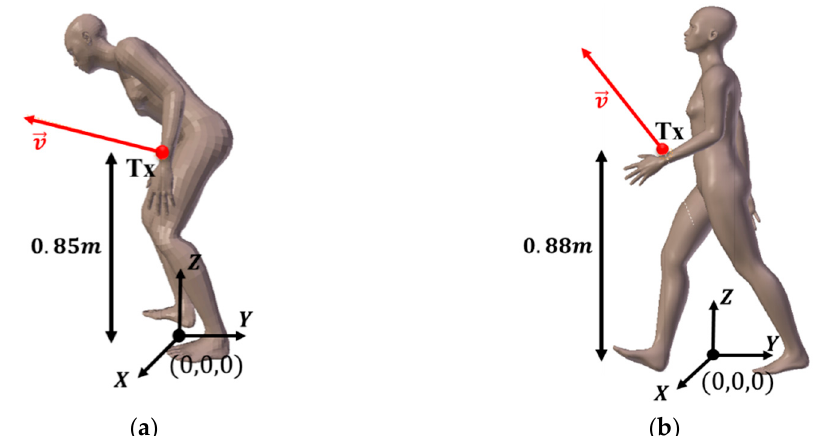
Figure 2. Illustration of 3D human body shape model: ( a ) elderly body shape model; ( b ) young body shape model. Table 2. Tx positions and orientation vector coordinates on a young and elderly body.